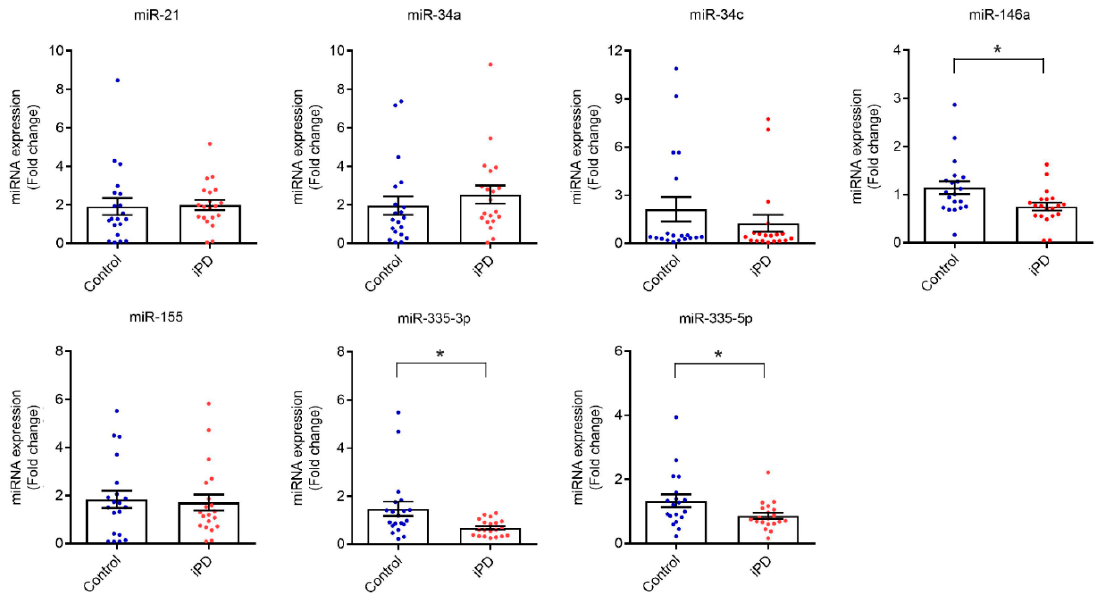
Figure 1. Relative expression values of miRNA in the serum of iPD patients and controls in the discovery cohort. Data are presented as the mean ± SEM. Cel-miR-39-3p was used as spike-in external control. Values were normalized relative to the mean of control healthy individuals. Differences were analyzed by Student’s t -test. * p < 0.05 vs. control.